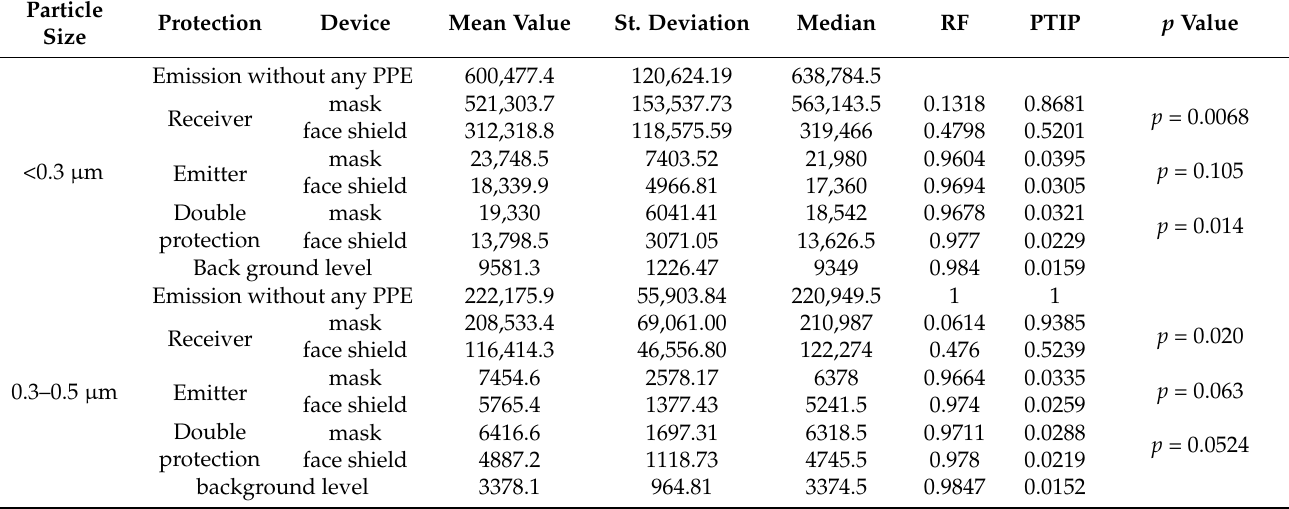
Table A1. Results of aerosol particle measurements on each particle size range in the different configurations.